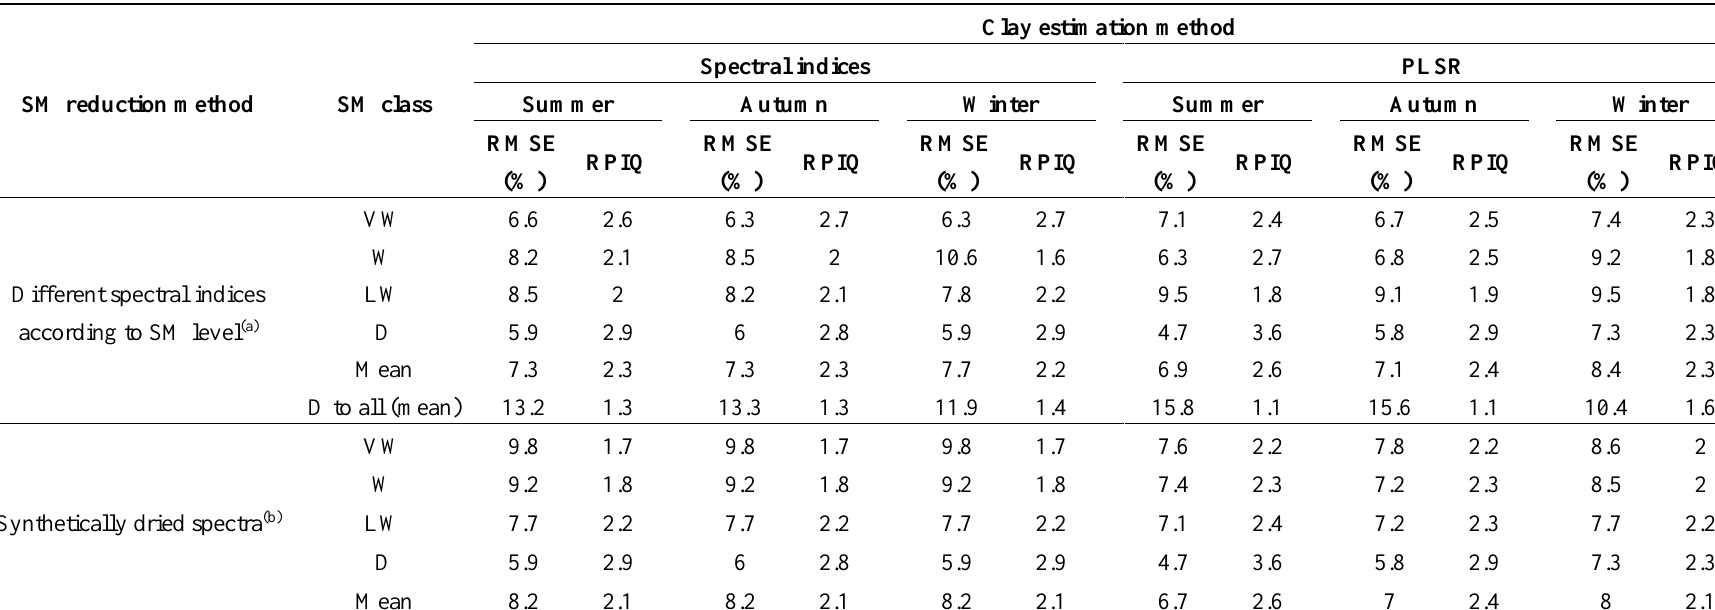
Table 6. Results from simulated PRISMA data using two different approaches for reducing the effect of soil moisture (SM) and two different clay estimation techniques (indices and PLSR). Atmospheric effect was added using seasonal parameterizations of the radiative transfer model